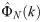
Ideal plot showing exaggerated, underestimated and optimal forecasts with varying Φ^N(k) and λ.